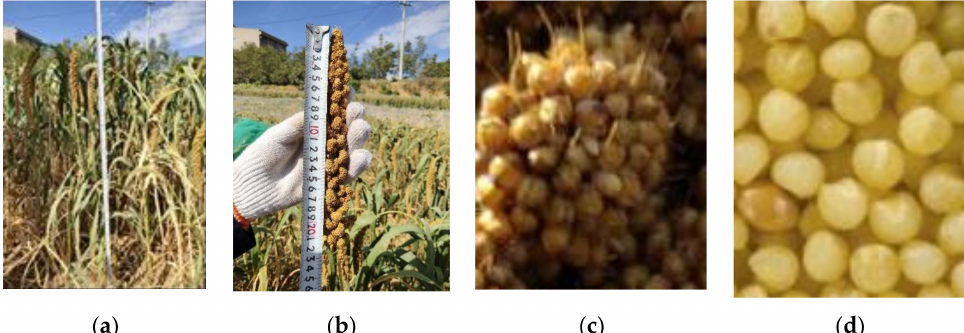
Figure 9. Yugu 23 millet: ( a ) the figure shows the millet plant; ( b ) the figure shows the millet ear head; ( c ) the figure shows the millet agglomerates; ( d ) the figure shows the millet grain. The basic parameters of millet are shown in Table